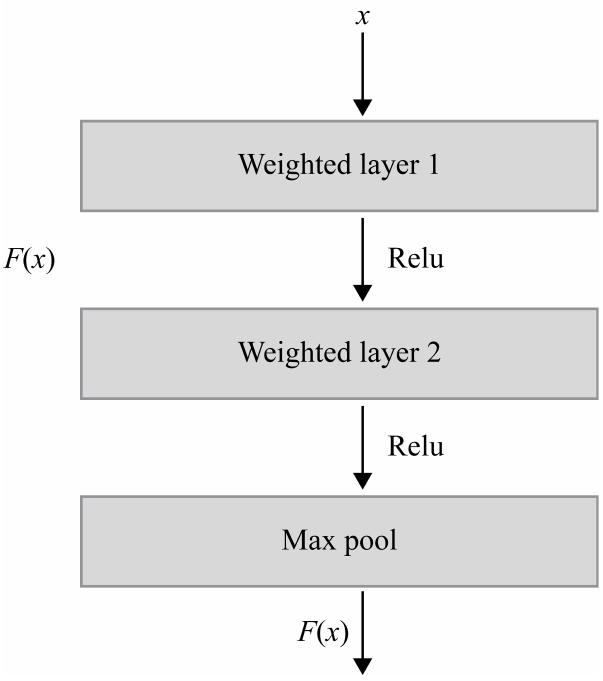
Figure 1. Bottleneck block in the VGGNet